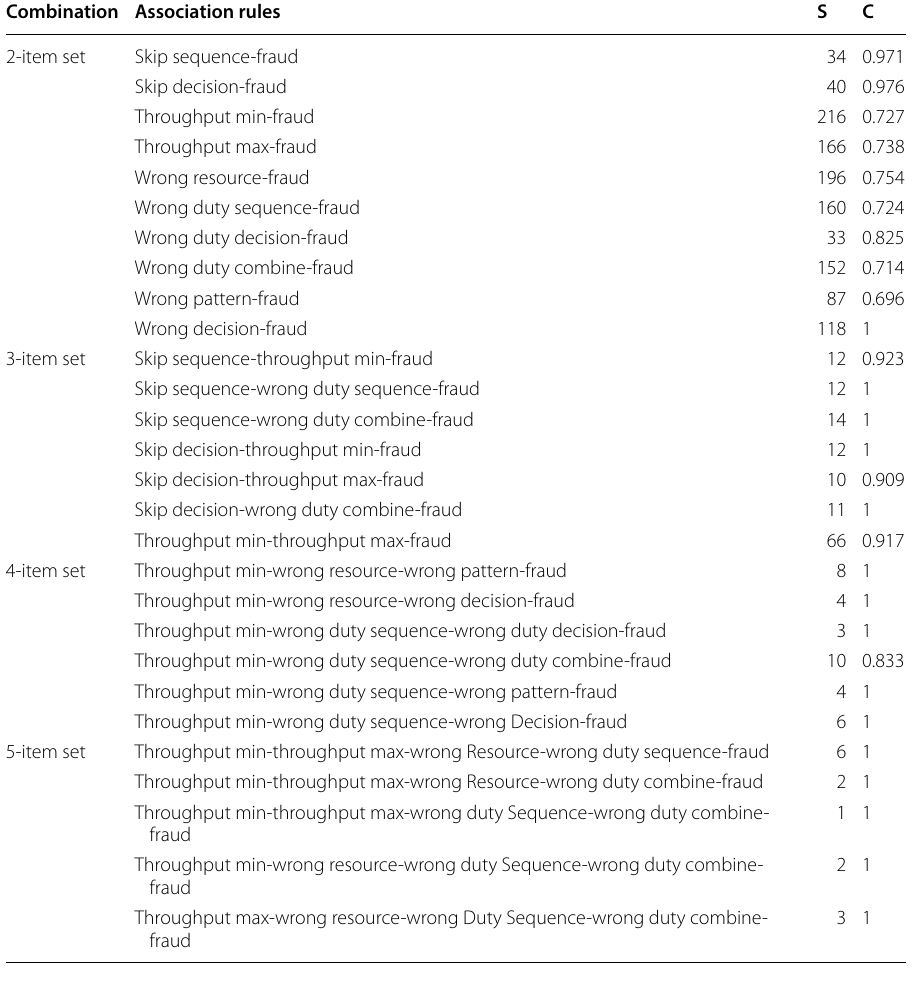
Table 14 Item sets and the corresponding association rules resulted by the ARL training Combination Association